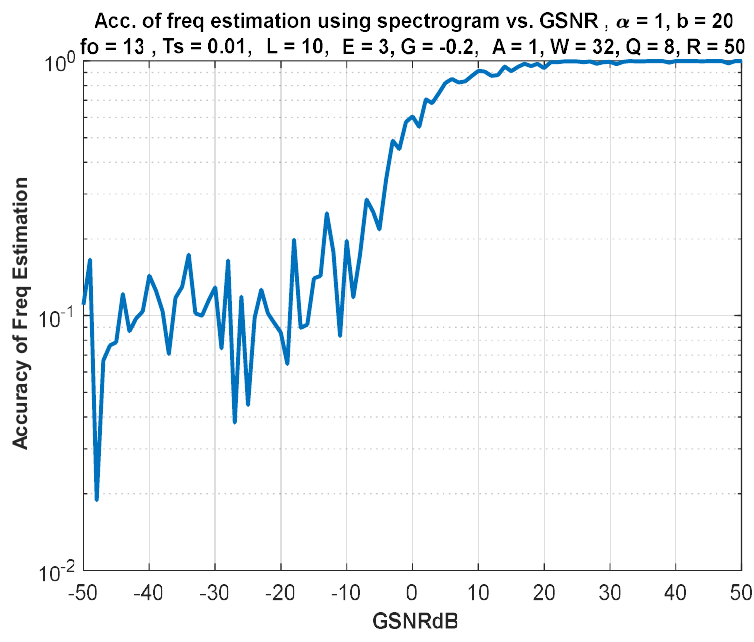
Figure 29. Accuracy of FE for noisy single tone signal by TFD (pspectrum).